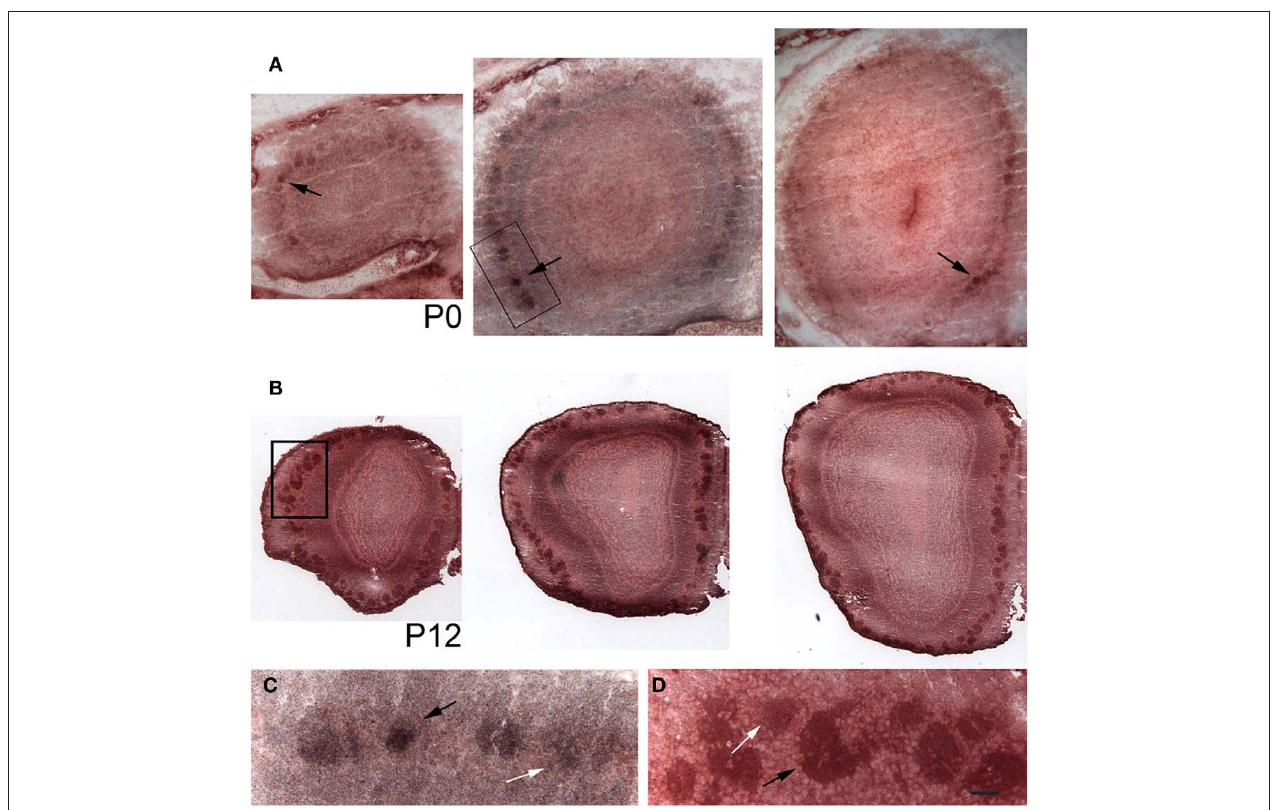
P12. Glomerular signal is in general higher at this age than at P0. (C) Higher magnification of boxed area shown in (A) . White and black arrows indicate glomeruli with different levels of pcdh10 expression. (D) Higher magnification of boxed area shown in (B) . White and black arrows indicate glomeruli